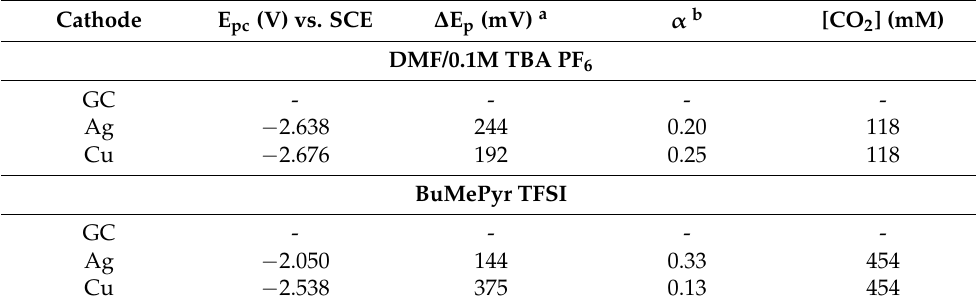
Table 4. Electrochemical parameters for solutions of CO 2 in both electrolytic medias, with the use of GC, Ag, and Cu cathodes).